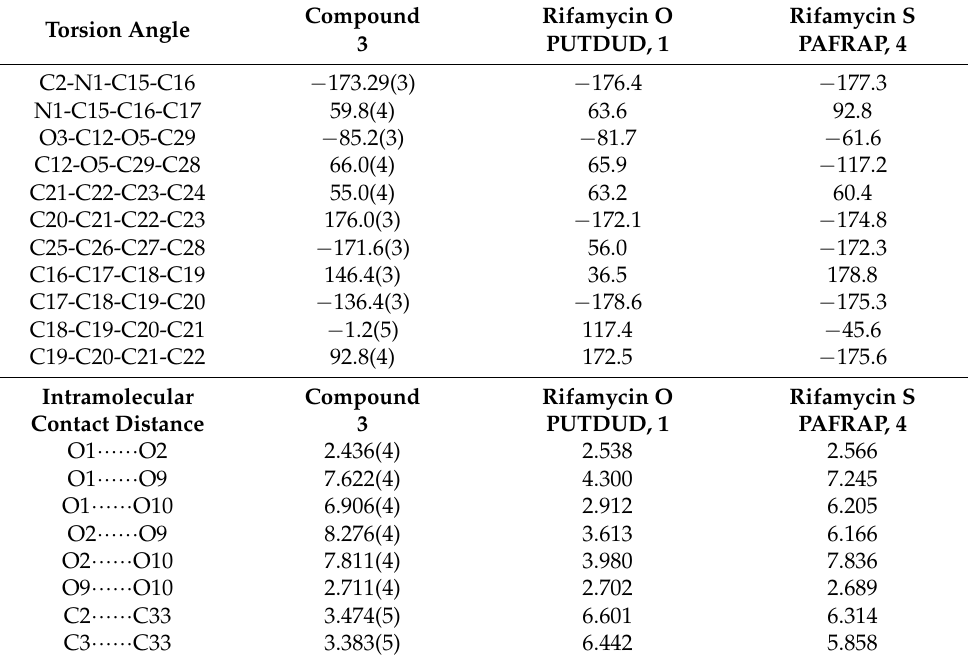
Table 2. Selected torsion angles ( ◦ ) and intramolecular contact distances (Å) for compound 3 and related structures *.